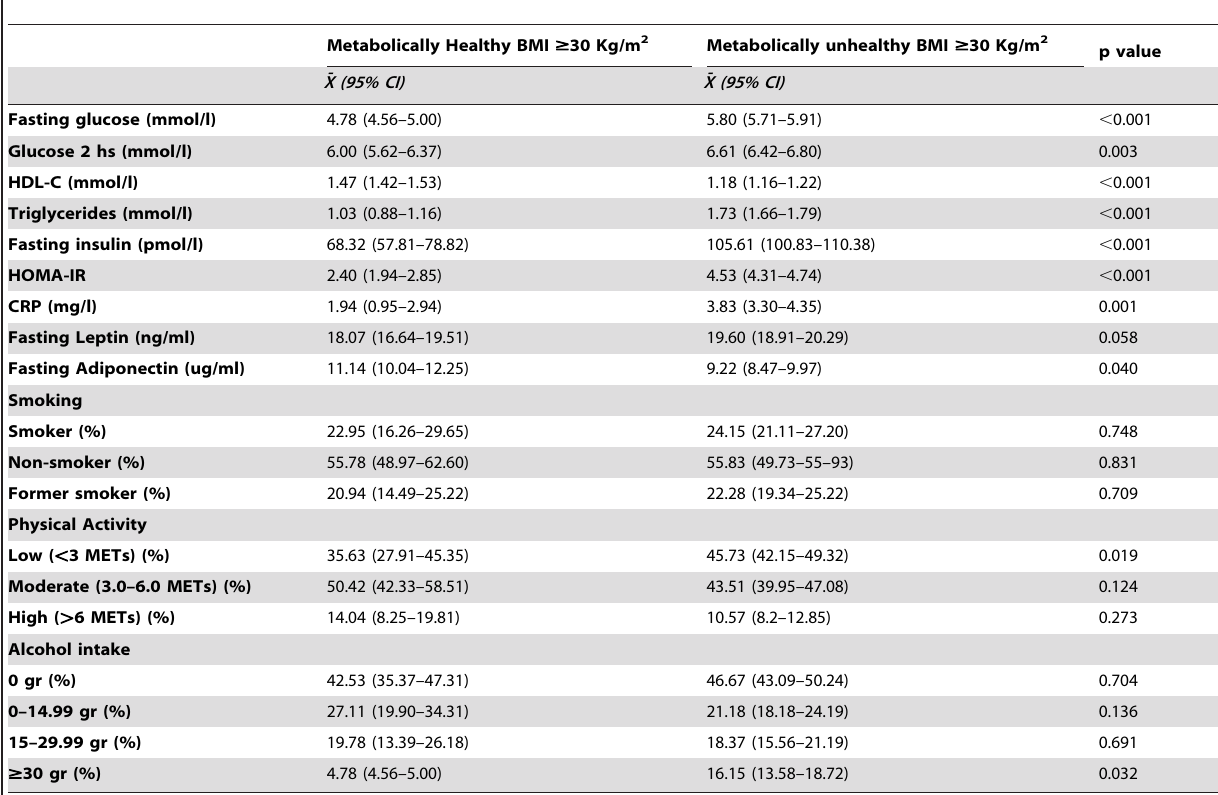
Table 6. Biochemical characteristics and lifestyle in individuals metabolically healthy and unhealthy with BMI $ 30 kg/m 2 by Wildman modified criteria, adjustment by age and